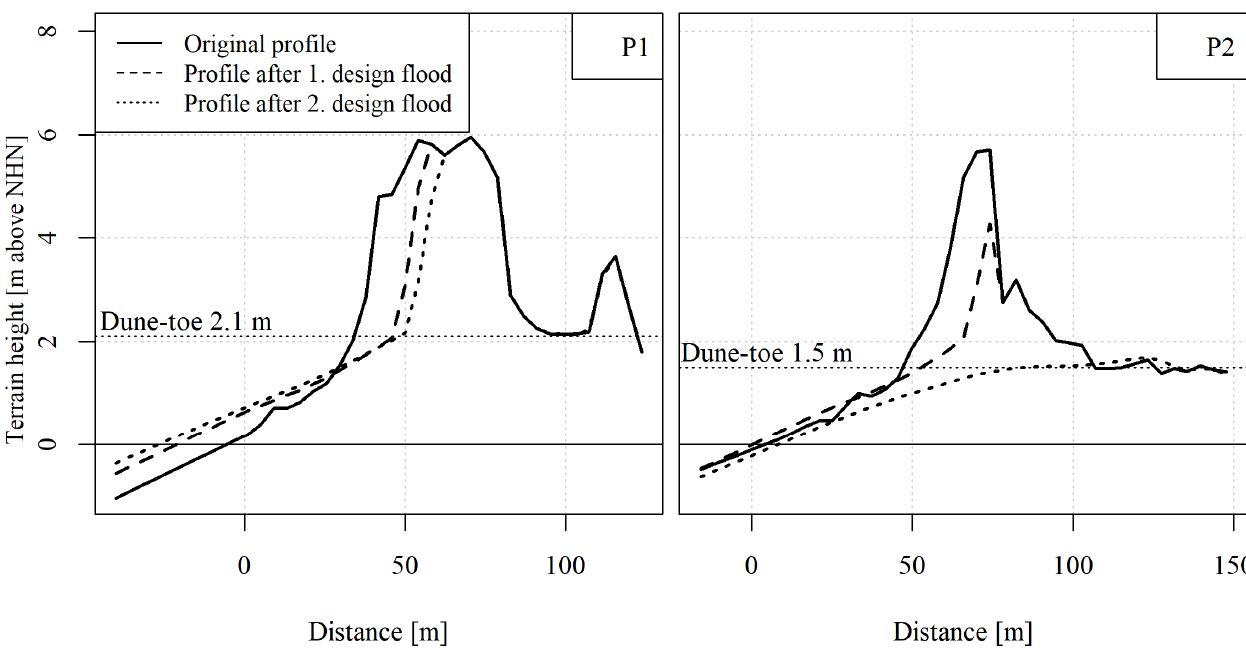
Figure 17. Different dune profiles after loads of the design floods, profiles P1 and P2.